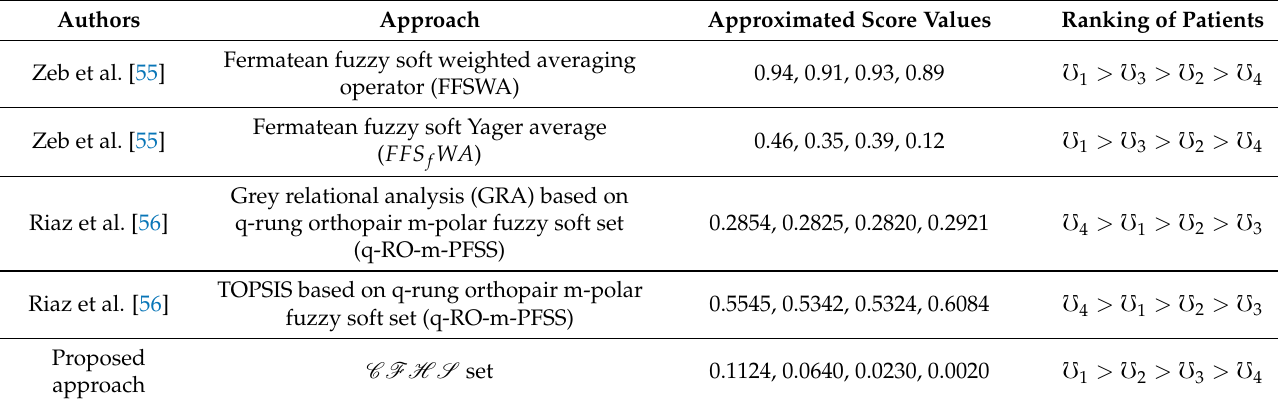
Table 20. Comparison of computational results of proposed